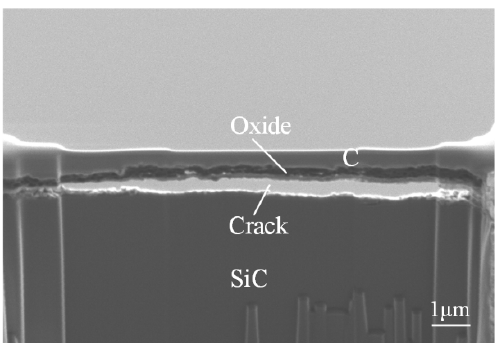
Figure 8. The microscopic view of the cross-sectional layer by focused ion beam (FIB) system.